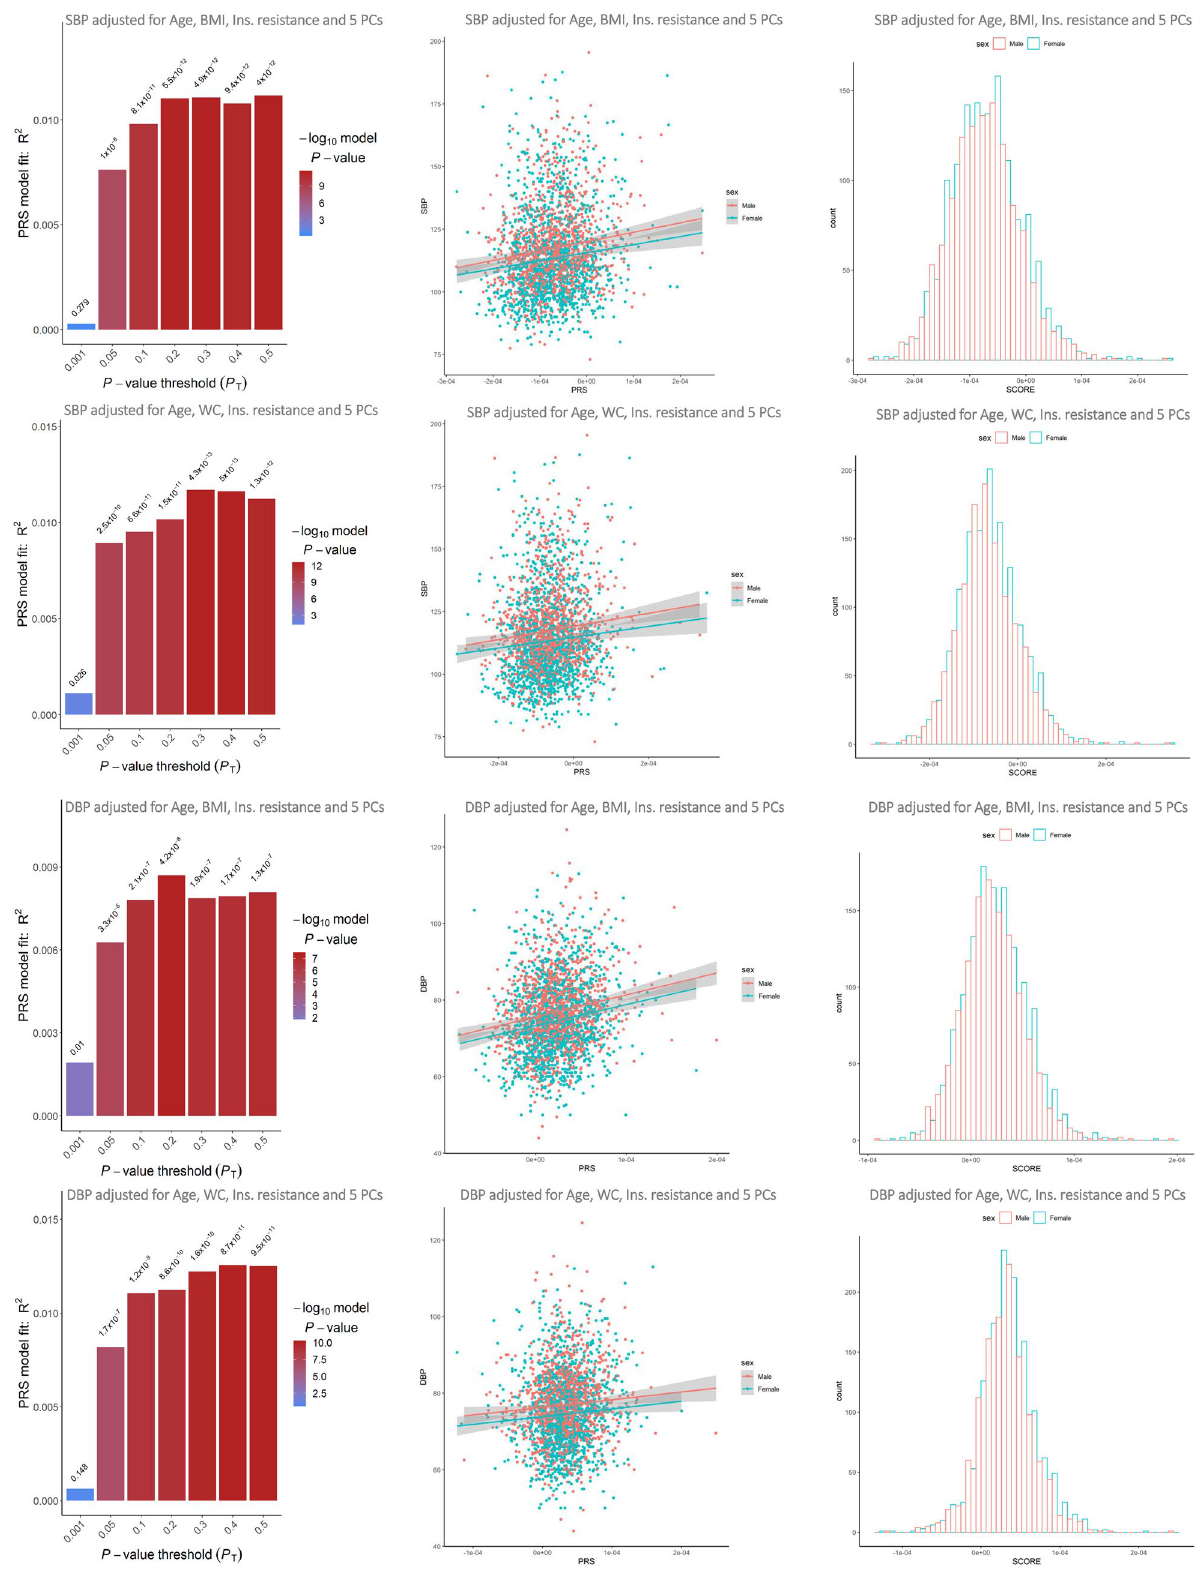
Figure 4. Predictive accuracy corresponding to a range of P value thresholds in regression models and the scatter plot of best fit PRS by sex in the independent sample of